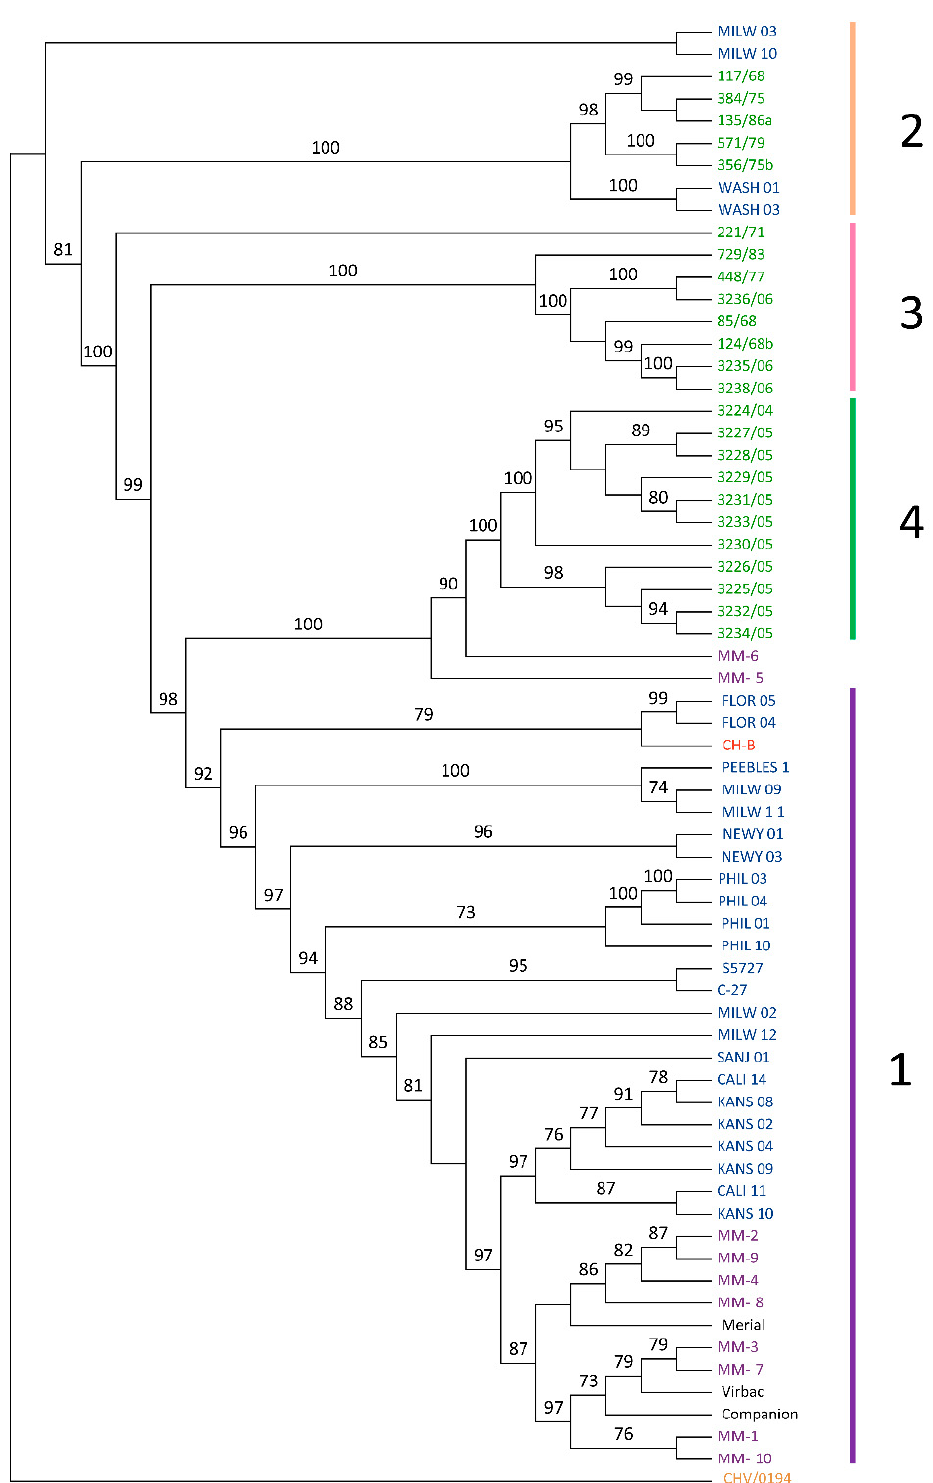
Figure 1. Maximum likelihood tree including all currently available feline herpesvirus type 1 (FHV-1) isolates along with canine herpesvirus (CHV-1/0194) as an outgroup (orange). Eight of ten cheetah isolates (purple) fell into Clade 1, with closest relations to one of the three modified live vaccines (MLV; black). Two cheetah isolates (MM-5 and MM-6) were sisters to FHV-1 strains previously isolated from domestic cats in Australia (green). Those strains in blue are previously analyzed FHV-1 isolates from domestic cats within the USA. CH-B strain (red) was previously isolated from China and falls outside of the clade structure but is closely genetically related to Clade